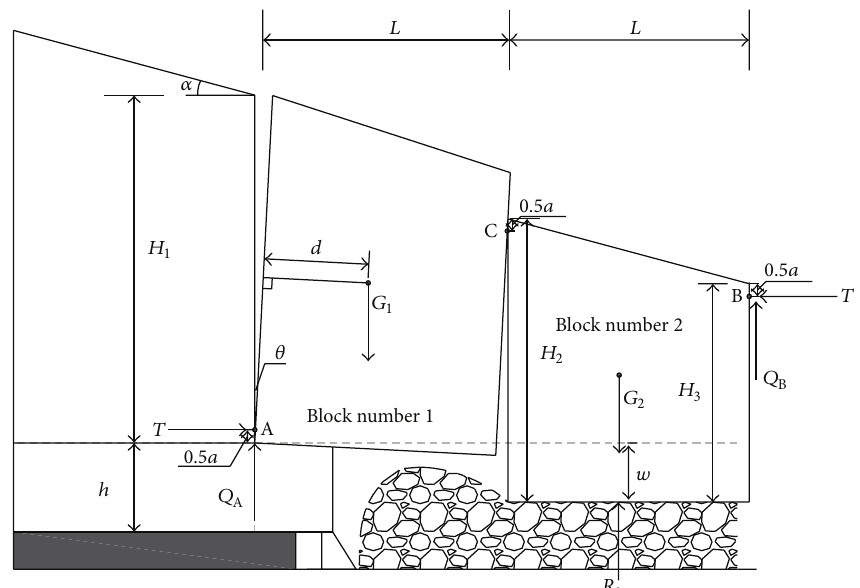
Figure 11: Mechanical model for key blocks in upslope mining.